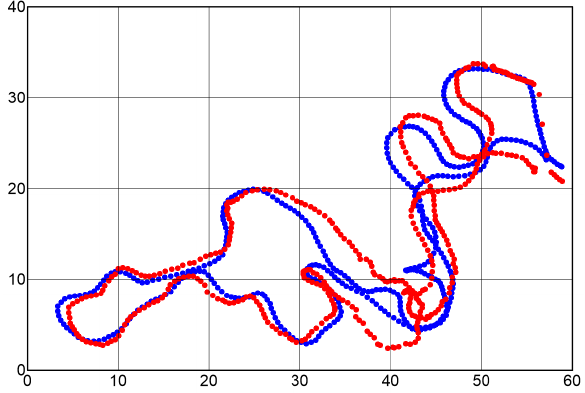
Figure 8 . Original GPS camera positions (red) and corrected ones after SfM (blue). E and N axis in meters. A similar analysis was done for the elevation, which was represented as a function of distance travelled. Figure 9 contains that graph, with distance and elevation in meters. Figure 9 . Original GPS camera elevation (red), and corrected ones after SfM (blue). Distance ( x ) and elevation ( y ) in meters. Position changes occur in different directions, so it may be expected that there will be some compensation effect in the model scale. Scale bars are created and the distance in the 3D model, d model , is calculated. The relative error, R , is calculated with the known reference distance, d reference , in the following